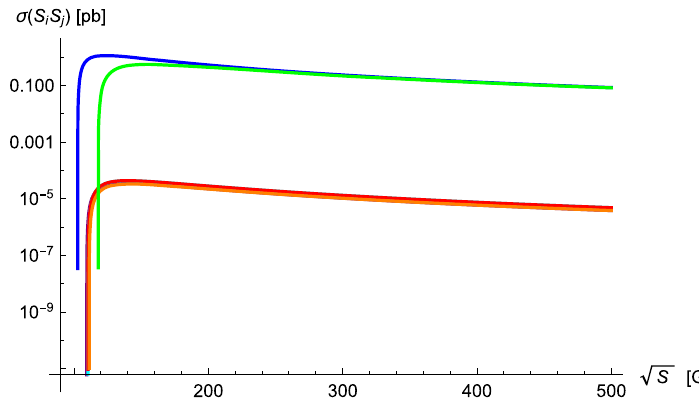
Fig. 4 The e + e − → Z ∗ → S i S j cross section for BP C with masses in GeV